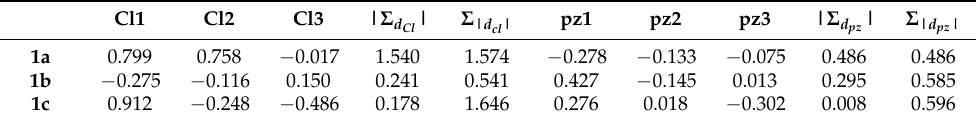
Table 4. Distances (d, Å ) of the terminal chloride ligands and pyrazolates from the Cu 3 -plane for 1a – c .